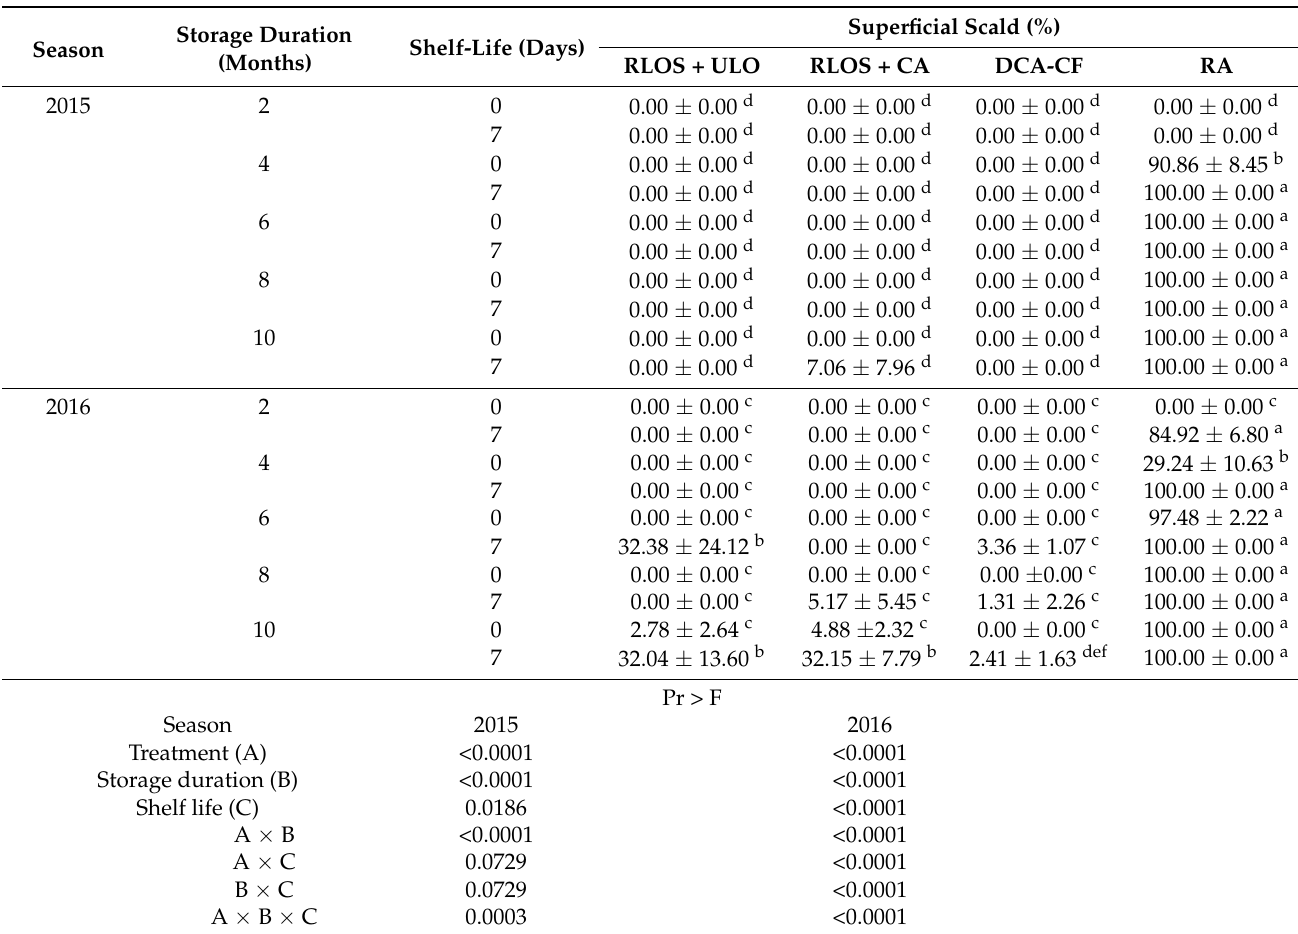
two seasons. Table 1. Superficial scald incidence (%) on ‘Granny Smith’ apples harvested at commercial maturity (with no superficial scald at harvest) and stored for up to 10 months at 0 ◦ C in various storage conditions, evaluated every two months followed by a 6 week simulated shipment and handling period, and at 7 days on the shelf (20 ◦ C and 65% RH).